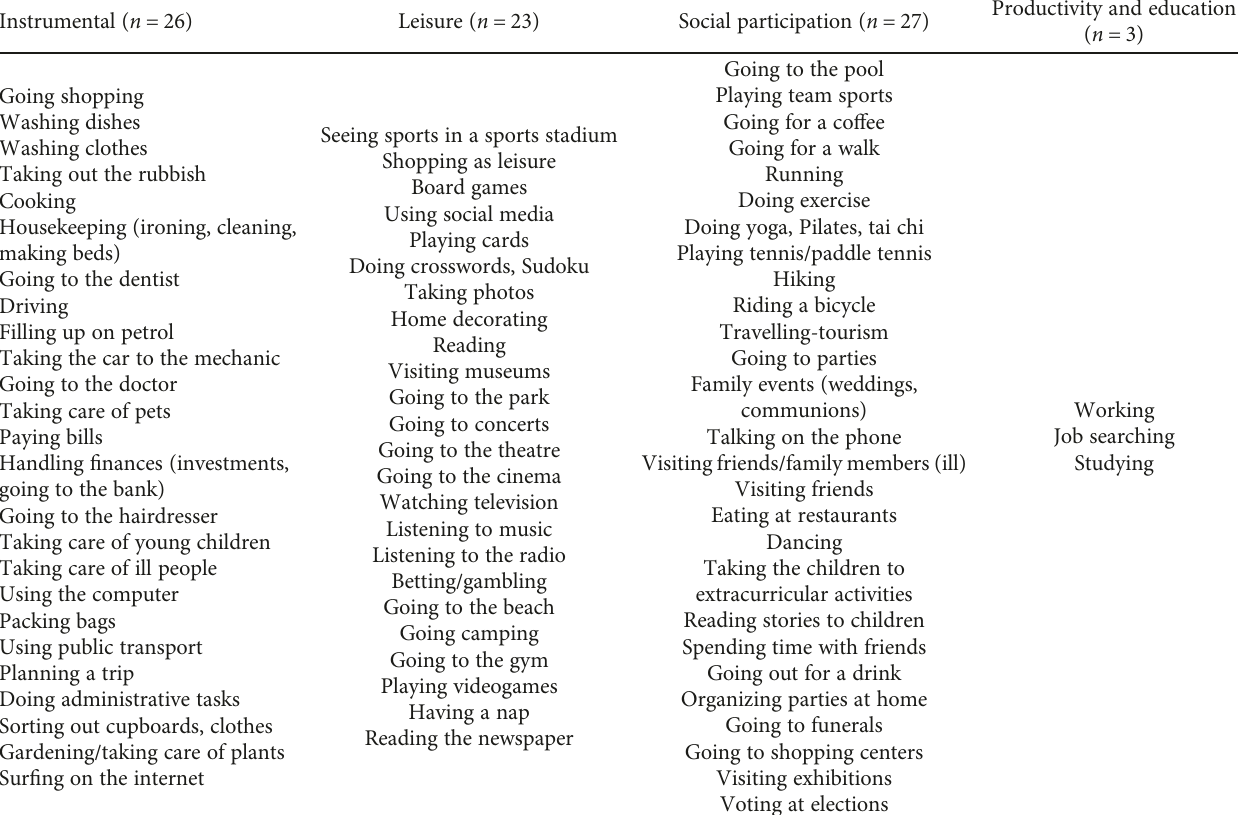
Table 3: Distribution of the activities included in the fi nal version of the ACS-SP by